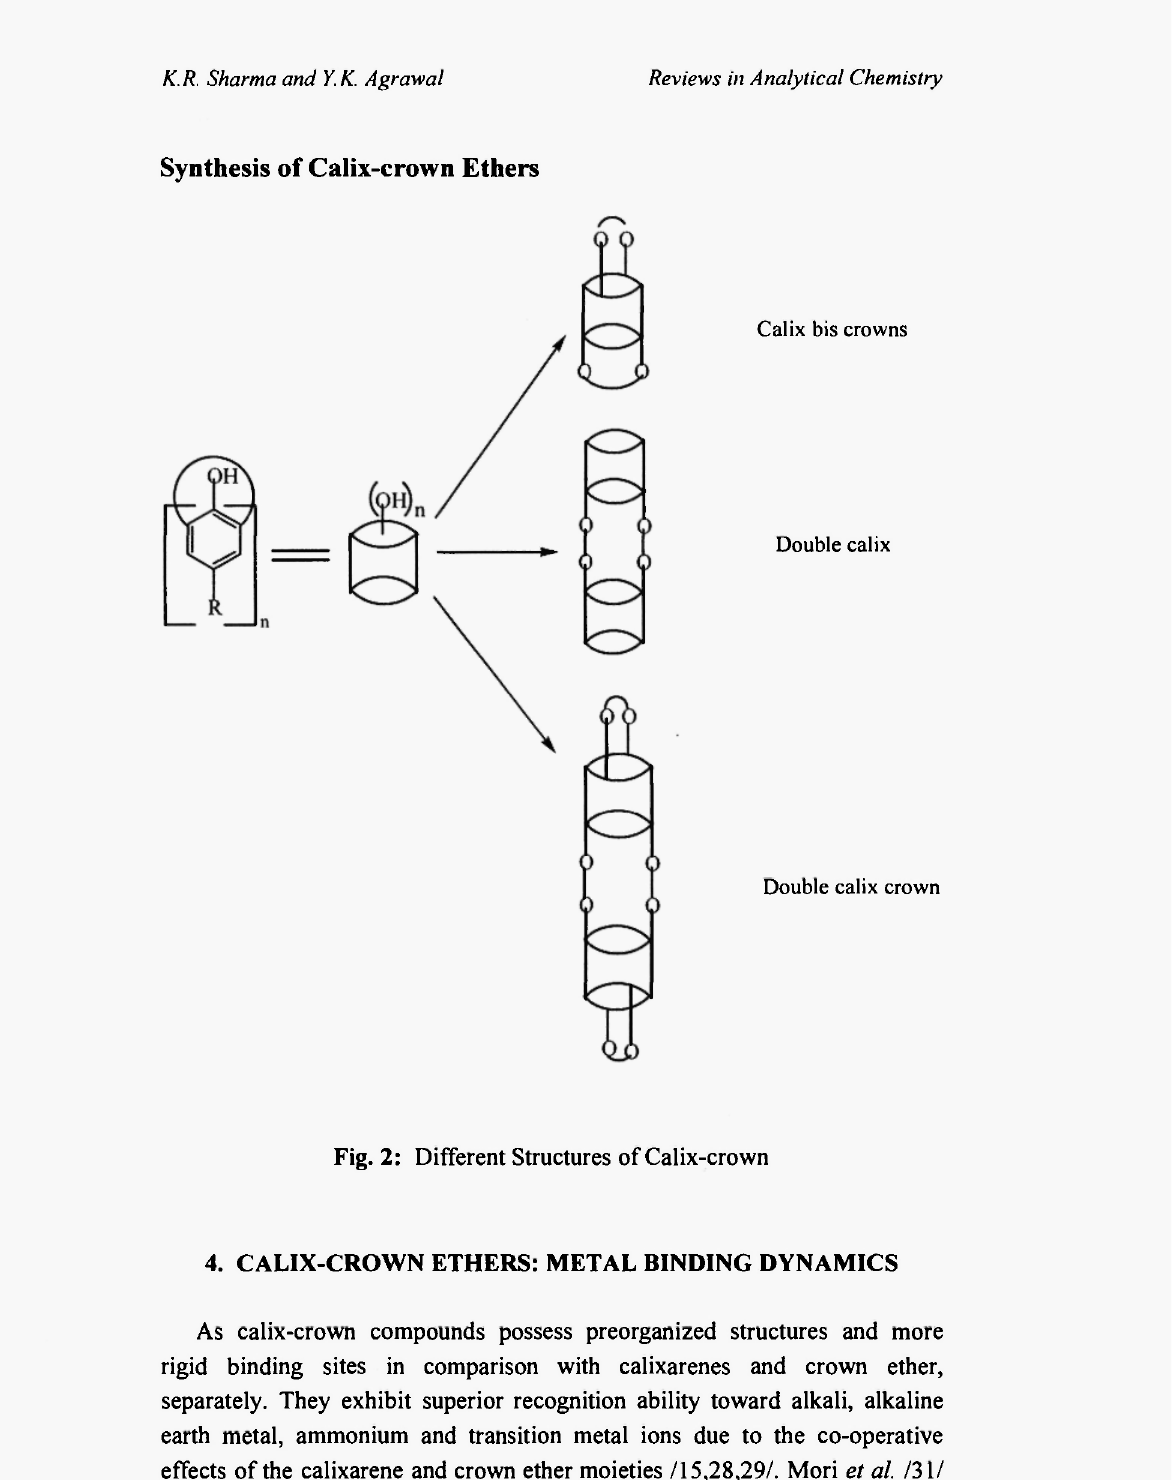
Fig. 2: Different Structures of